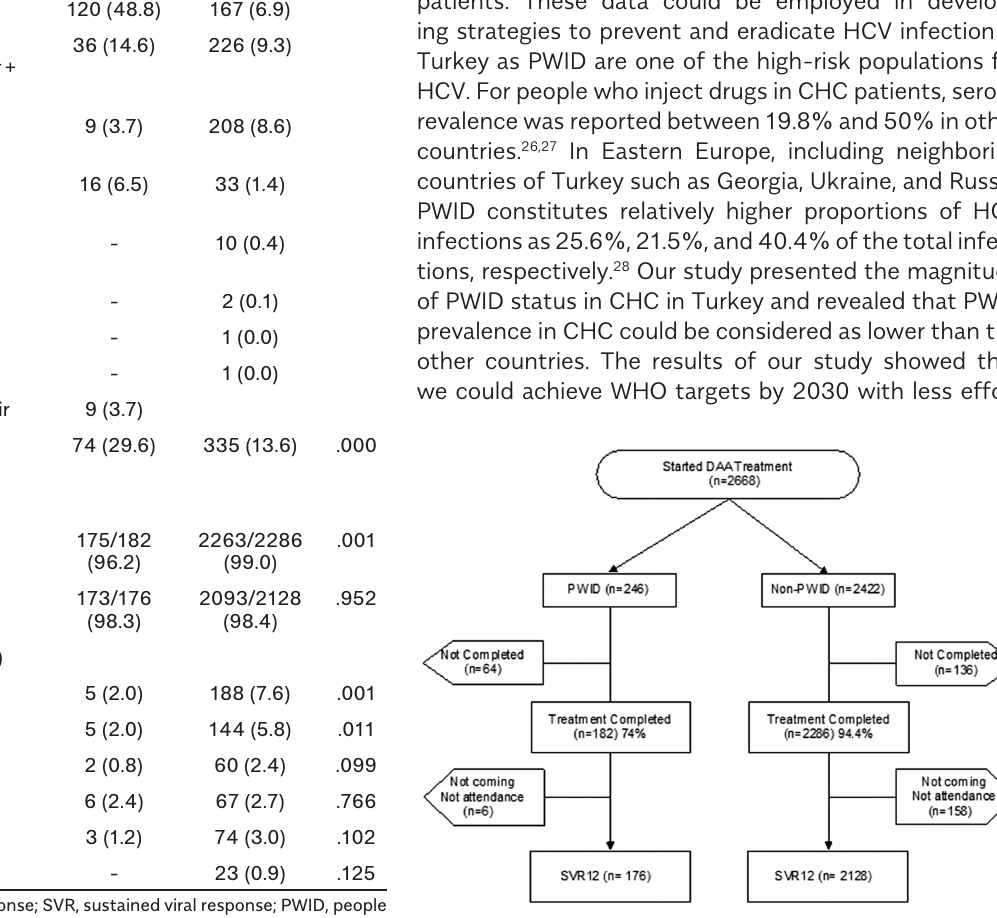
Figure 1. Treatment flow